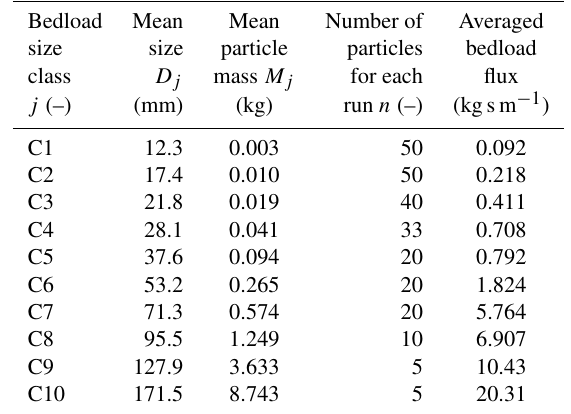
Table 2. Bedload particle characteristics for each grain size class j .